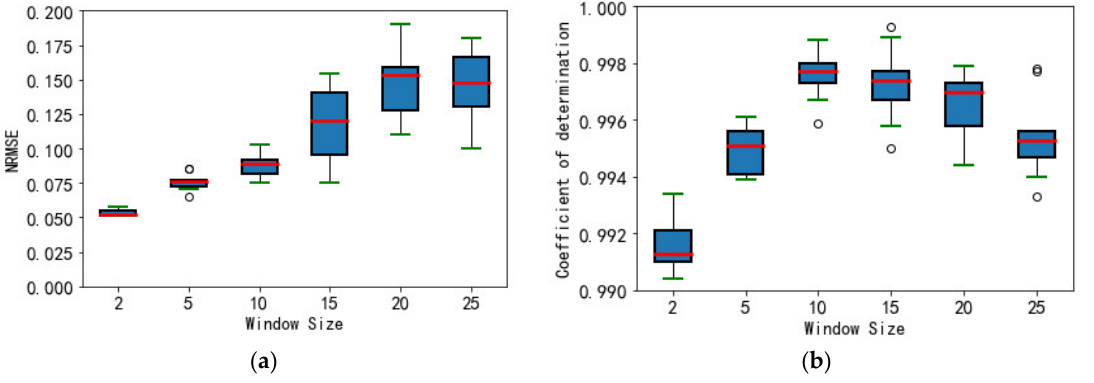
Figure 11. Box diagram of evaluation of window size in the algorithm: ( a ) NRMSE; ( b ) Coefficient of Determination.